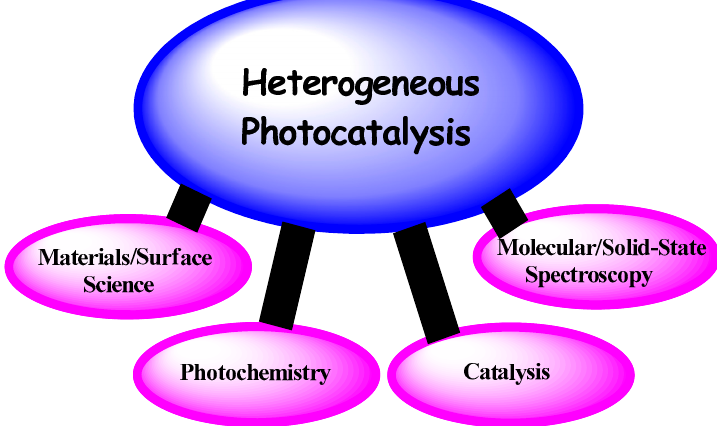
Figure 5. The four pillars that have had a great impact on the development of heterogeneous